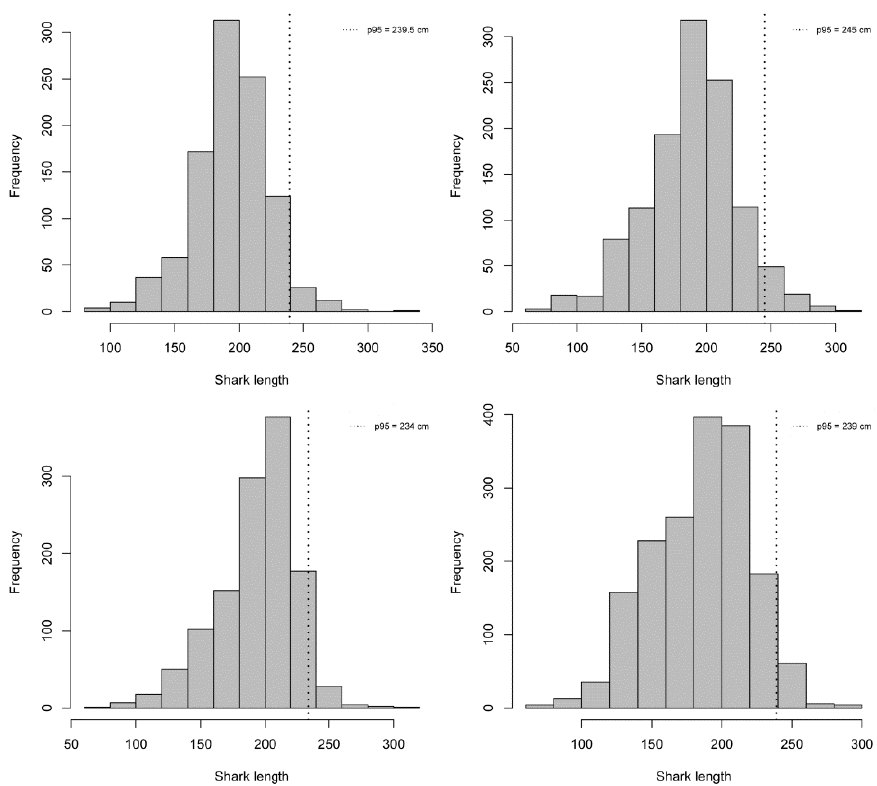
Figure 1. Histograms of total length (cm) for male ( left ) and female ( right ) silky sharks landed in 2015 ( top ) and 2016 ( bottom ). The 95th percentile of length for each histogram is shown as a dashed vertical line.